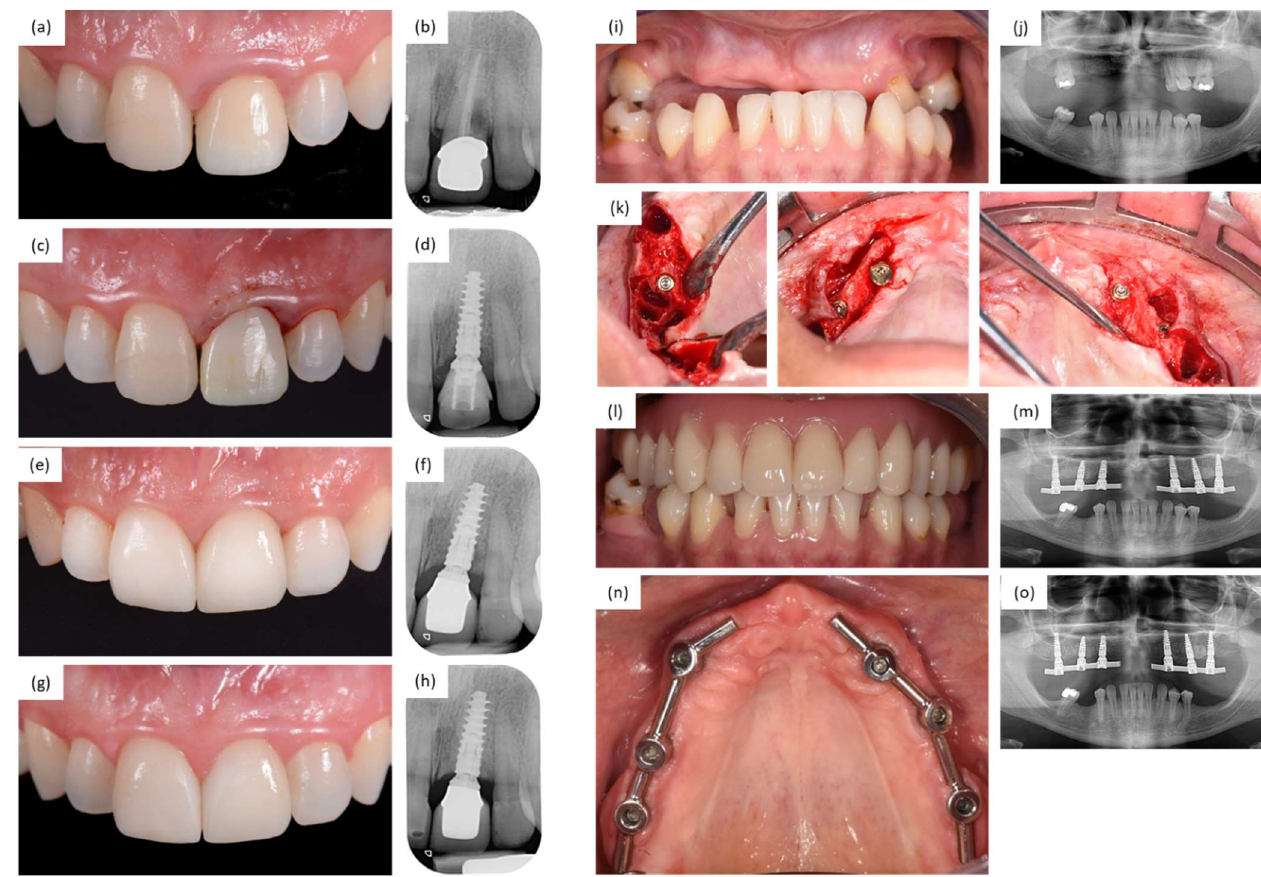
Figure 3. Sample clinical cases from the study. ( a – h ) A 44-year-old female patient was treated with a single implant to replace a failing maxillary incisor at FDI (Federation Dentaire